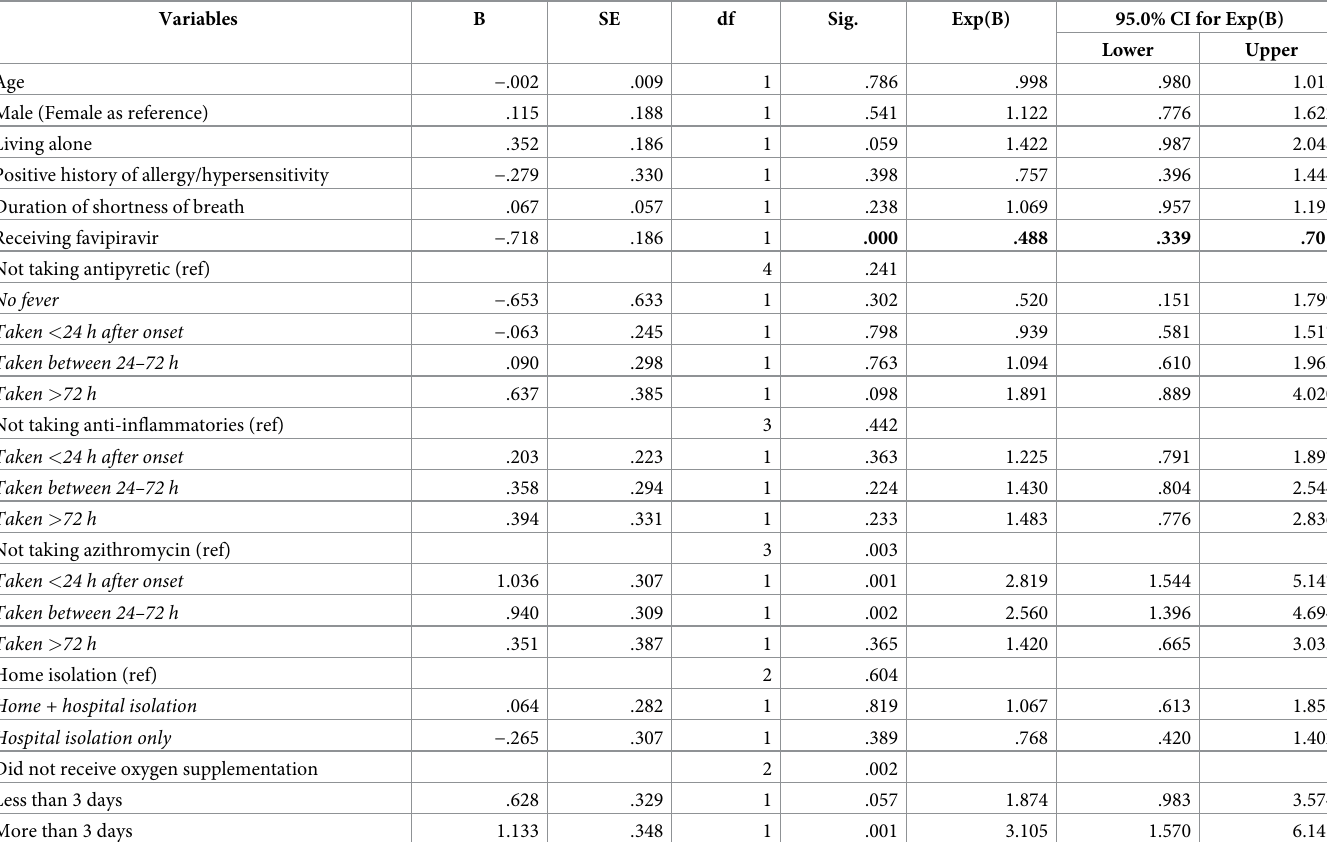
Table 3. Effect of favipiravir on post-COVID